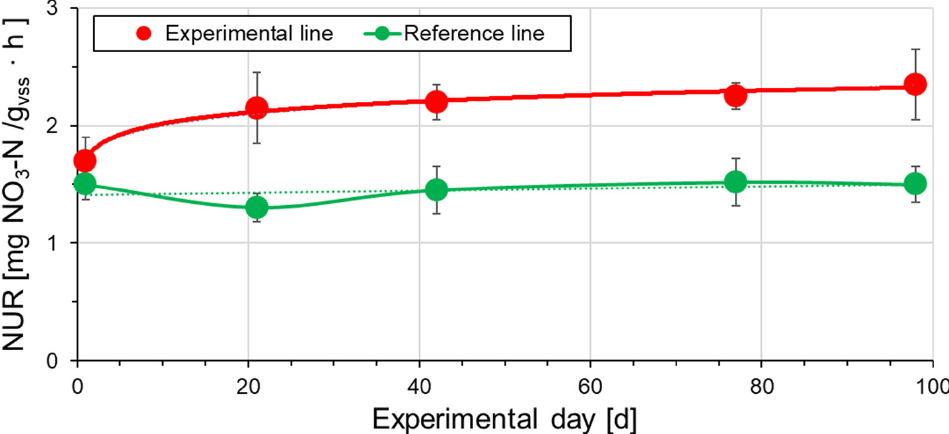
Figure 2. Denitrification rates measured in laboratory conditions for biomass from the experimental line (with fusel oil dosing) and reference line (without dosing of fusel oil) at Poznan WWTP.